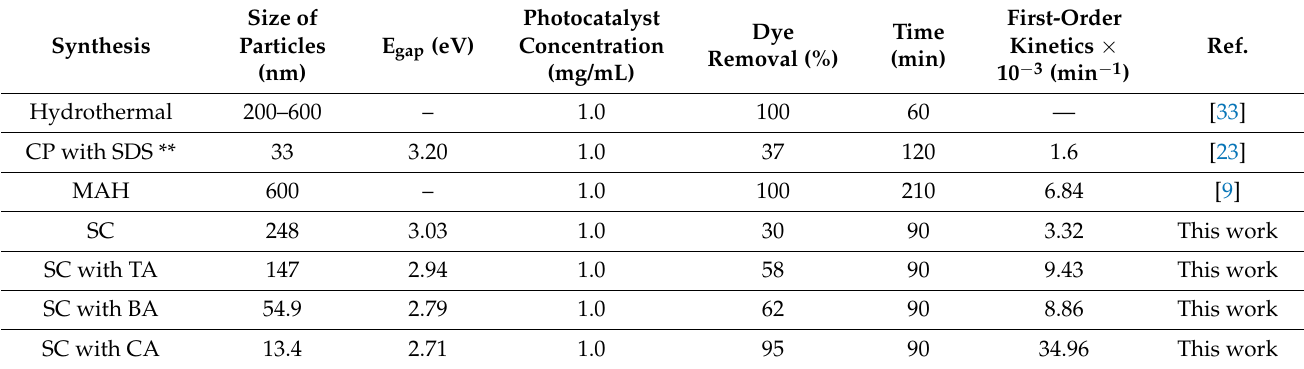
Table 2. Comparative results for the RhB degradation in the presence of α -Ag 2 WO 4